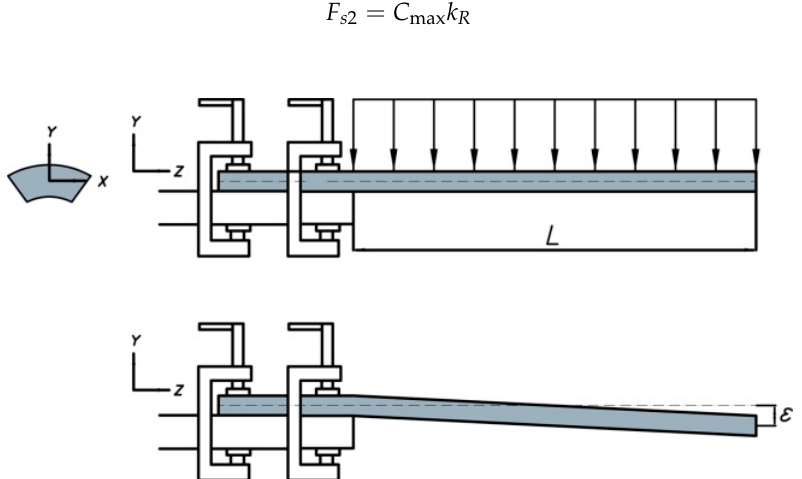
Figure 10. Equivalent representation of a jaw of the collet.